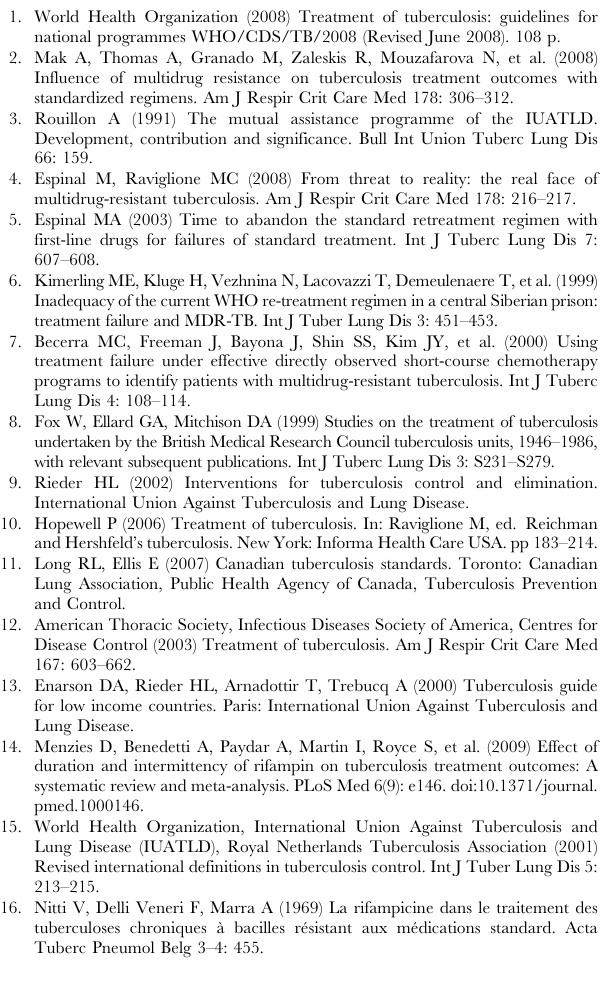
Table S1 Summary of randomized trials pooled for analysis of isoniazid